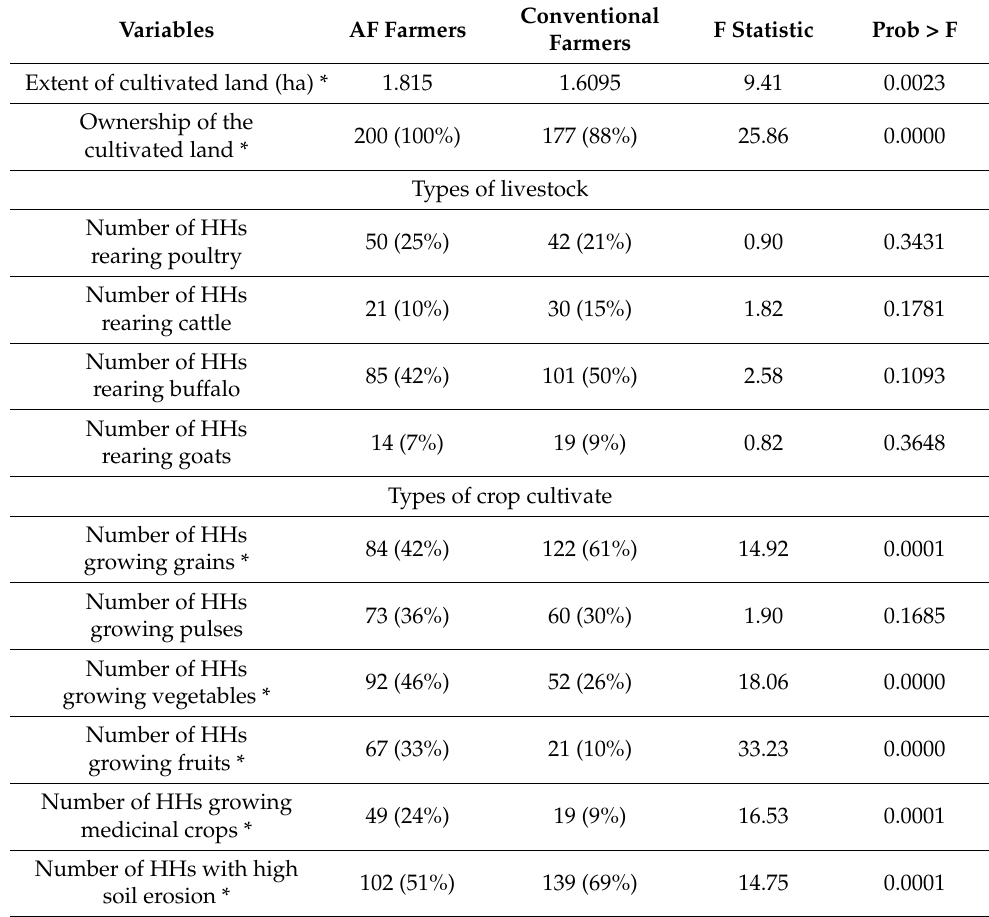
Table 4. Comparative analysis of the natural capital of AF and CF